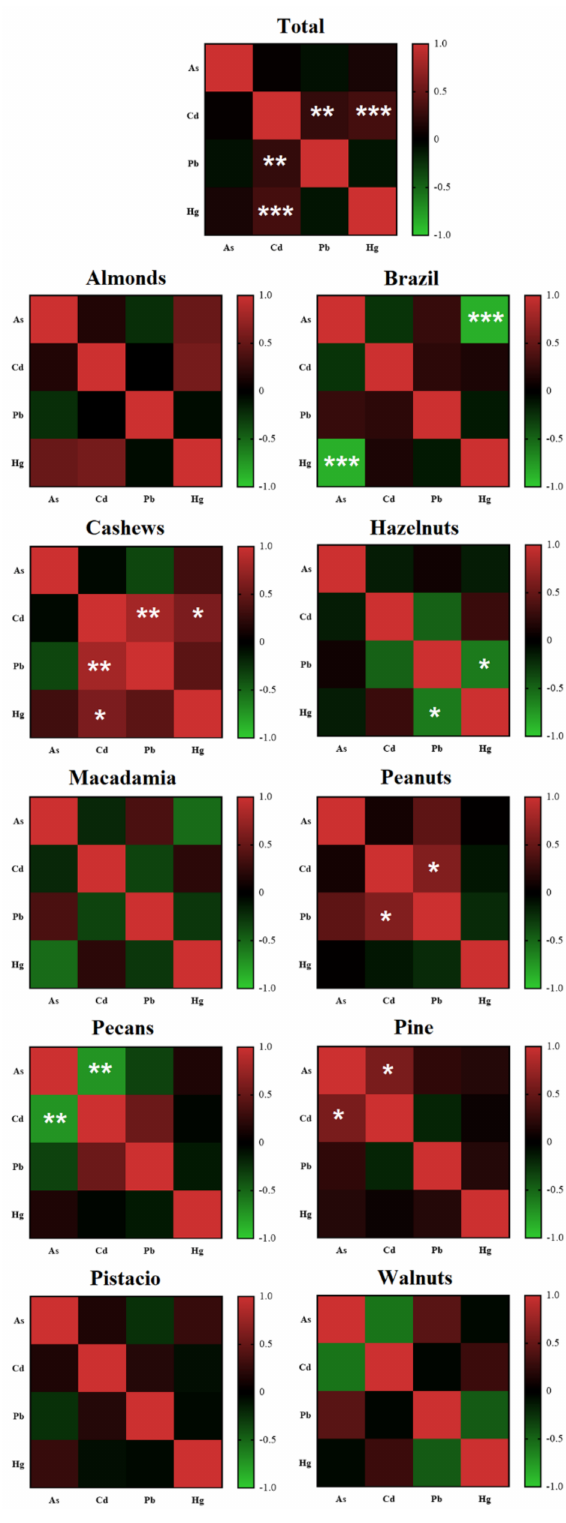
Figure 1. A heatmap of the Spearman correlation between the content of toxic elements. A—almonds; B—Brazil nuts; C—cashews; H—hazelnuts; M—macadamia; Pea—peanuts; Pec—pecans; Pin—pine; Pis—pistachio; W—walnuts, * p <0.05, ** p <0.01, *** p